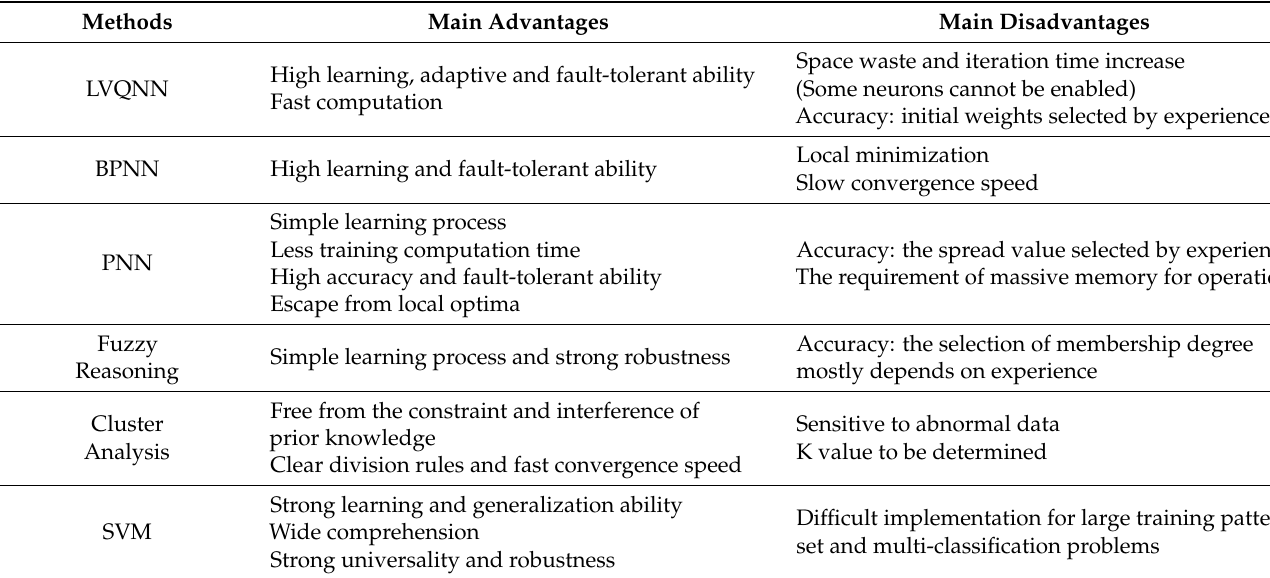
Table 1. Main DCR methods characteristics summary.